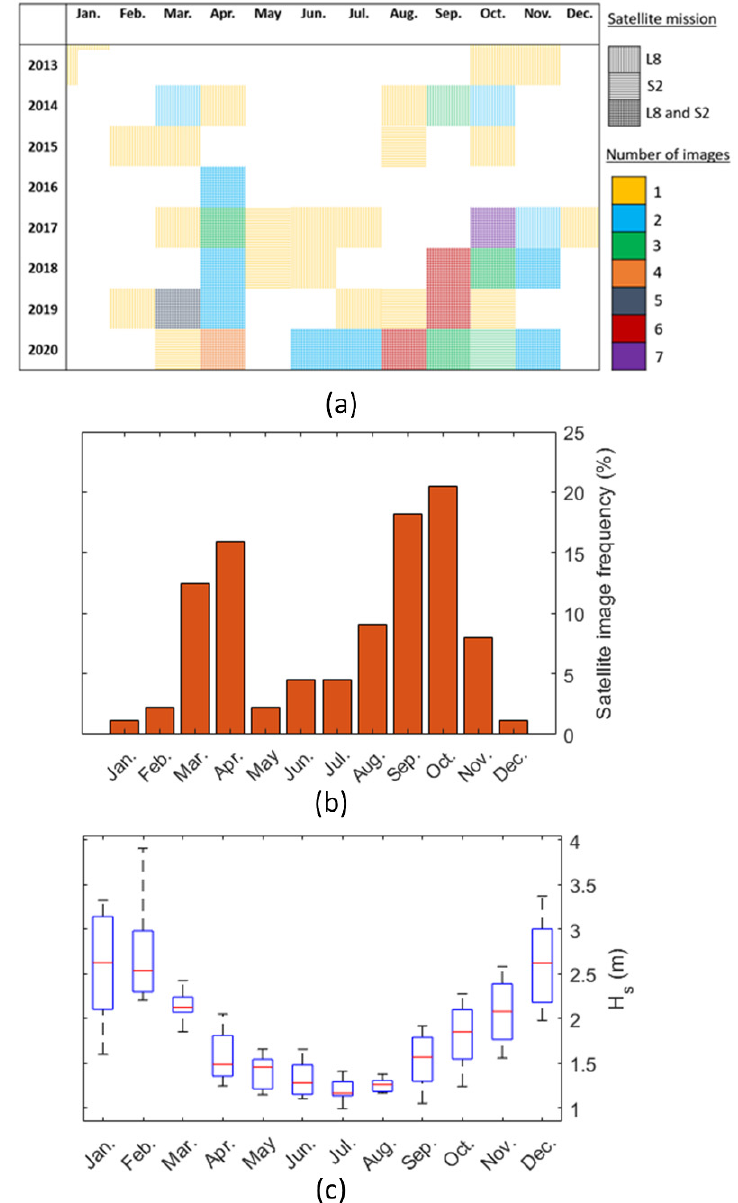
Figure 2. ( a ) Acquisition dates of the different Landsat-8 and Sentinel-2 A/B images belonging to the dataset; ( b ) distribution of these images per month; and ( c ) average monthly value of the significant wave height ( H s ) computed over the period 2013–2020.